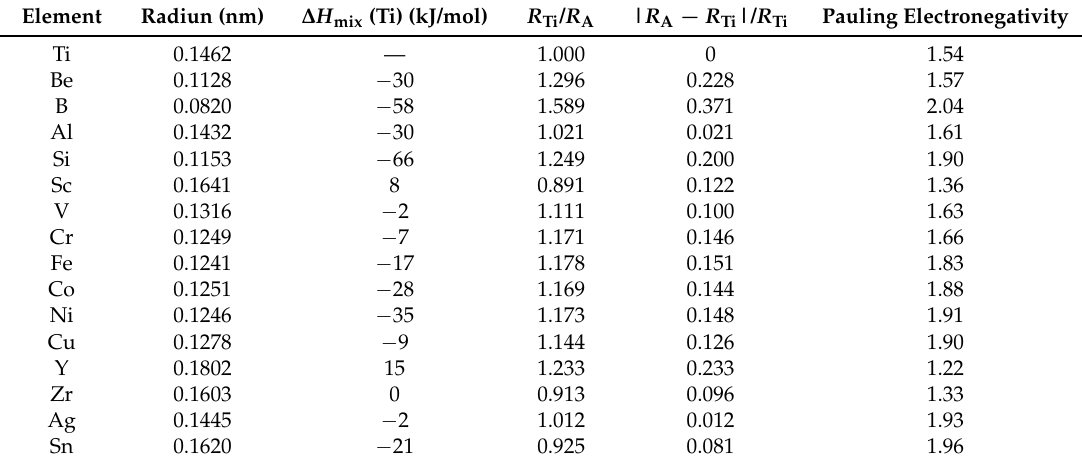
Table 2. Atomic radii, Pauling electronegativity, and heats of mixing for some elements [115].